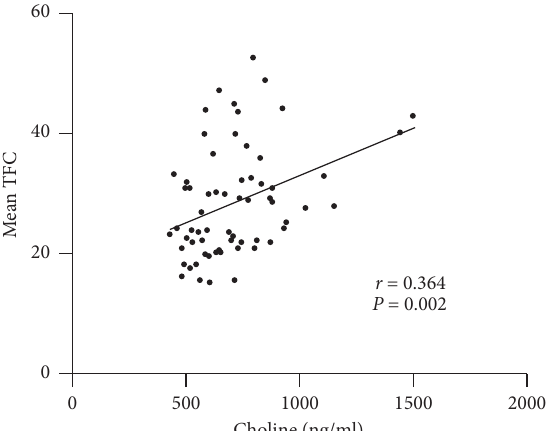
Figure 3: The relationship analysis between plasma choline level and mean TFC. r , Pearson correlation